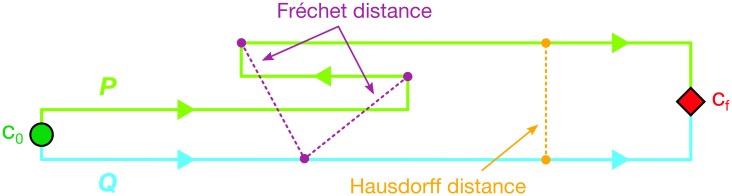
Comparison of Hausdorff and Fréchet distance. Two paths P (green) and Q (cyan) begin at state c0 and end at state cf with directionality indicated by the arrows.The Fréchet distance δF and Hausdorff distance δH are given by the lengths of the purple and orange lines, respectively. The purple lines are the same length and correspond to the minimally stretched Fréchet “leash”; the orange line spans a pair of points separated by the Hausdorff distance (only one is shown because in this case there are infinitely many pairs of points with the same δH). Due to the backtracking of path P toward state A, combined with the monotonicity (no-backward-movement) constraint of the Fréchet metric, δF > δH.